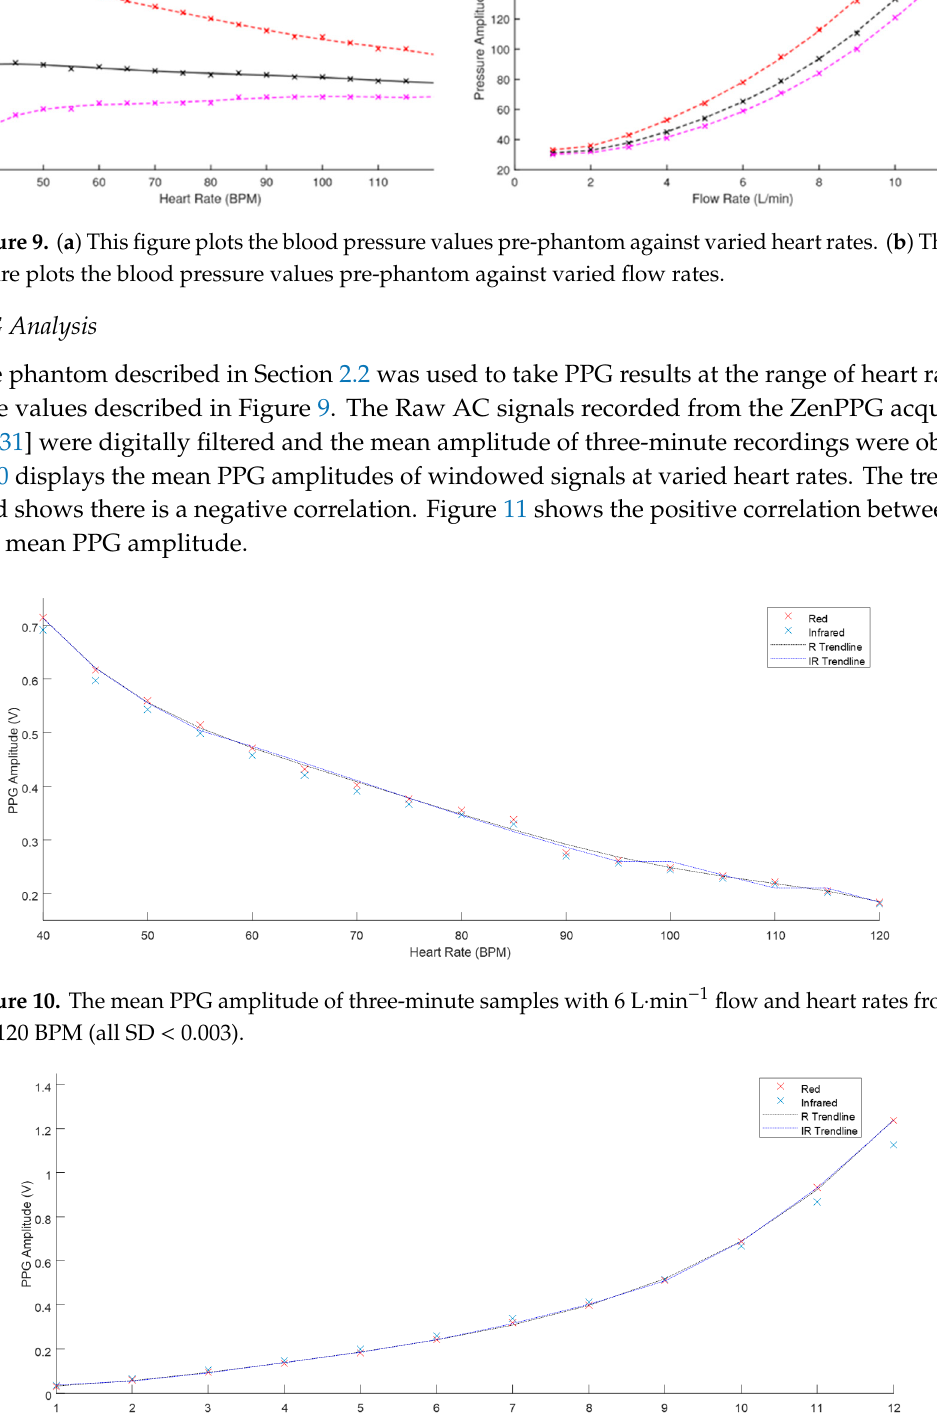
Figure 11. The mean PPG amplitude of three-minute samples with 60 BPM heart rate and flow from 1–12 L·min − 1 (SD < 0.003).